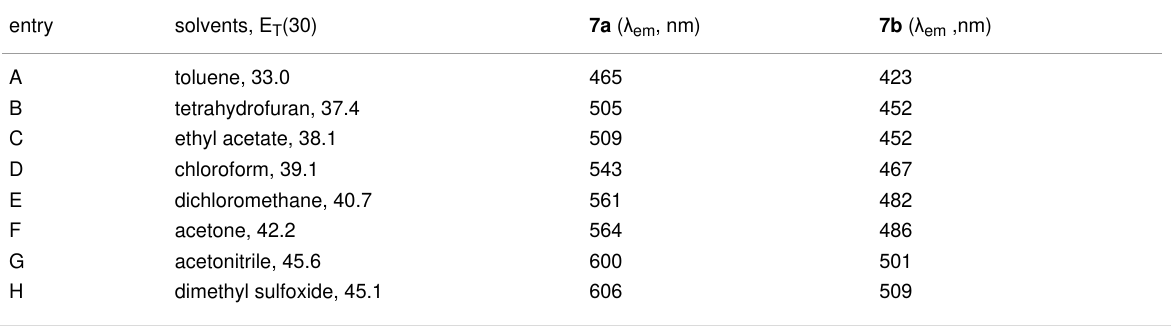
Table 3: Maximum emission wavelength ( λ emmax ) of compounds 7a and 7b under different